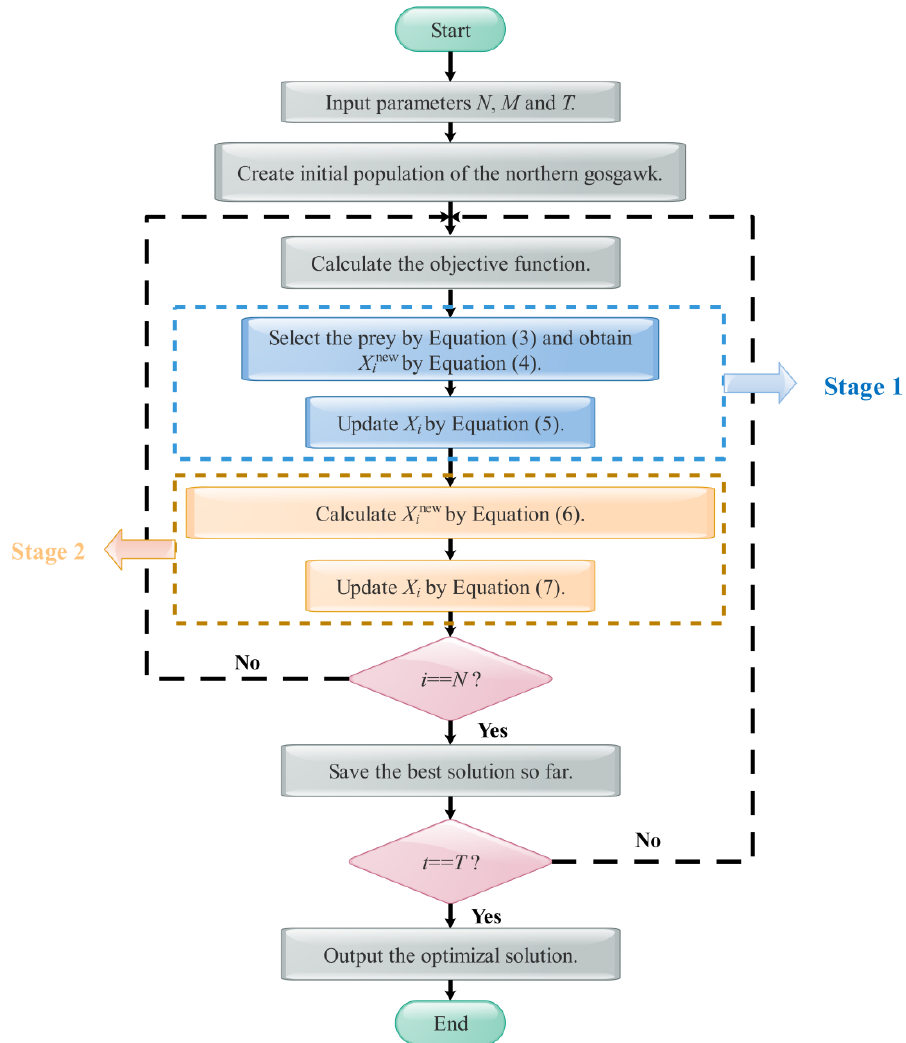
Figure 2 provides the flow chart of the original NGO algorithm.